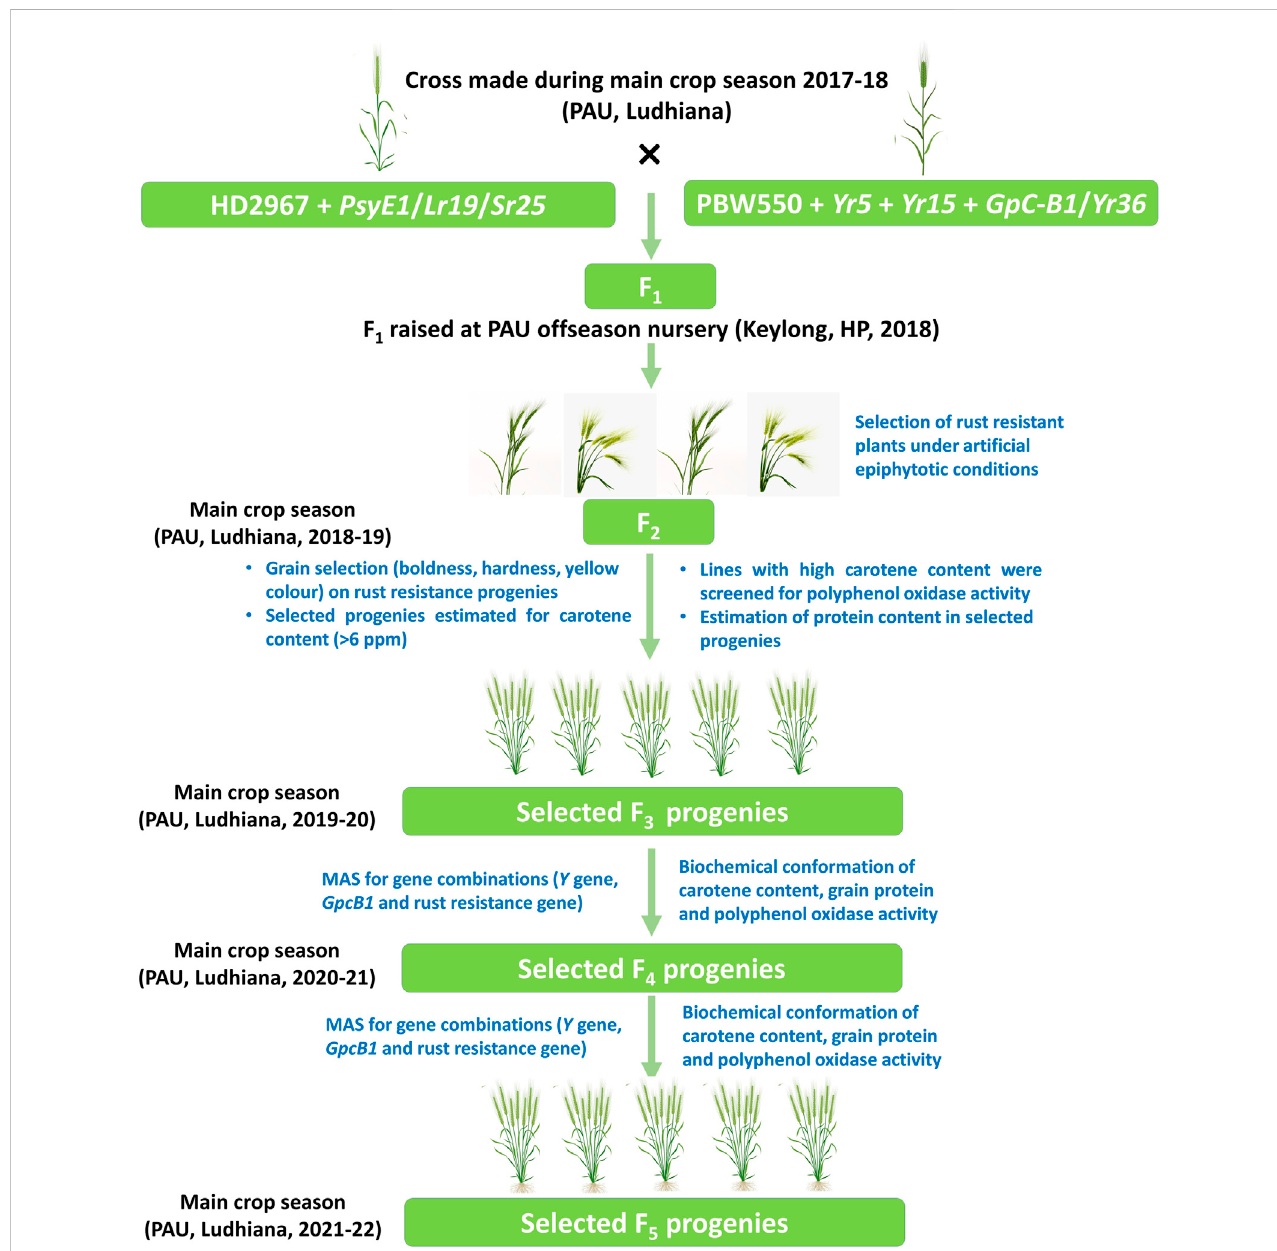
FIGURE 1 Representation of the steps performed for pyramiding PBW550 + GpcB1/Yr36 + Yr15 and HD2967 + PsyE1/Lr19/Sr25 .